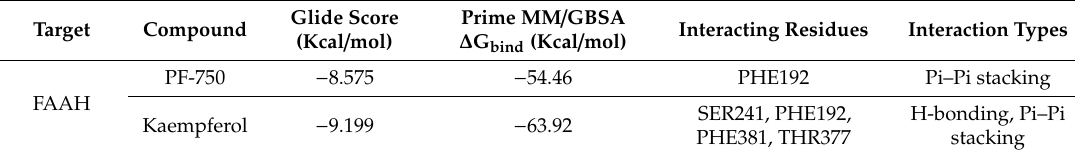
Table 1. Parameters for in silico docking simulation and computed free binding energy by Prime /